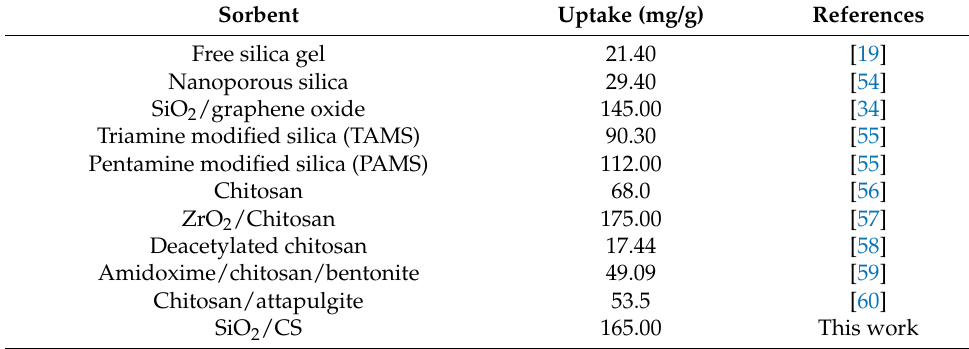
Table 4. Comparison of U(VI) uptake capacity of SiO 2 /CS among other adsorbents.